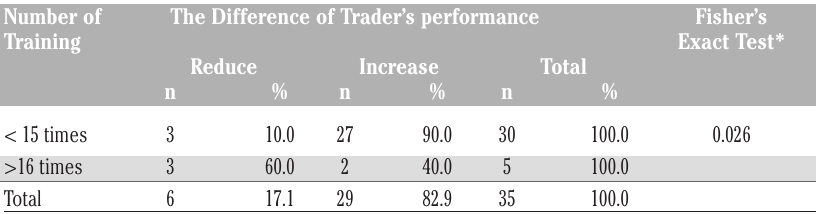
Table 5. The relationship between the number of training and assessing the seller’s per- formance in Mokoau Health Care Centre Area in 2019. Number